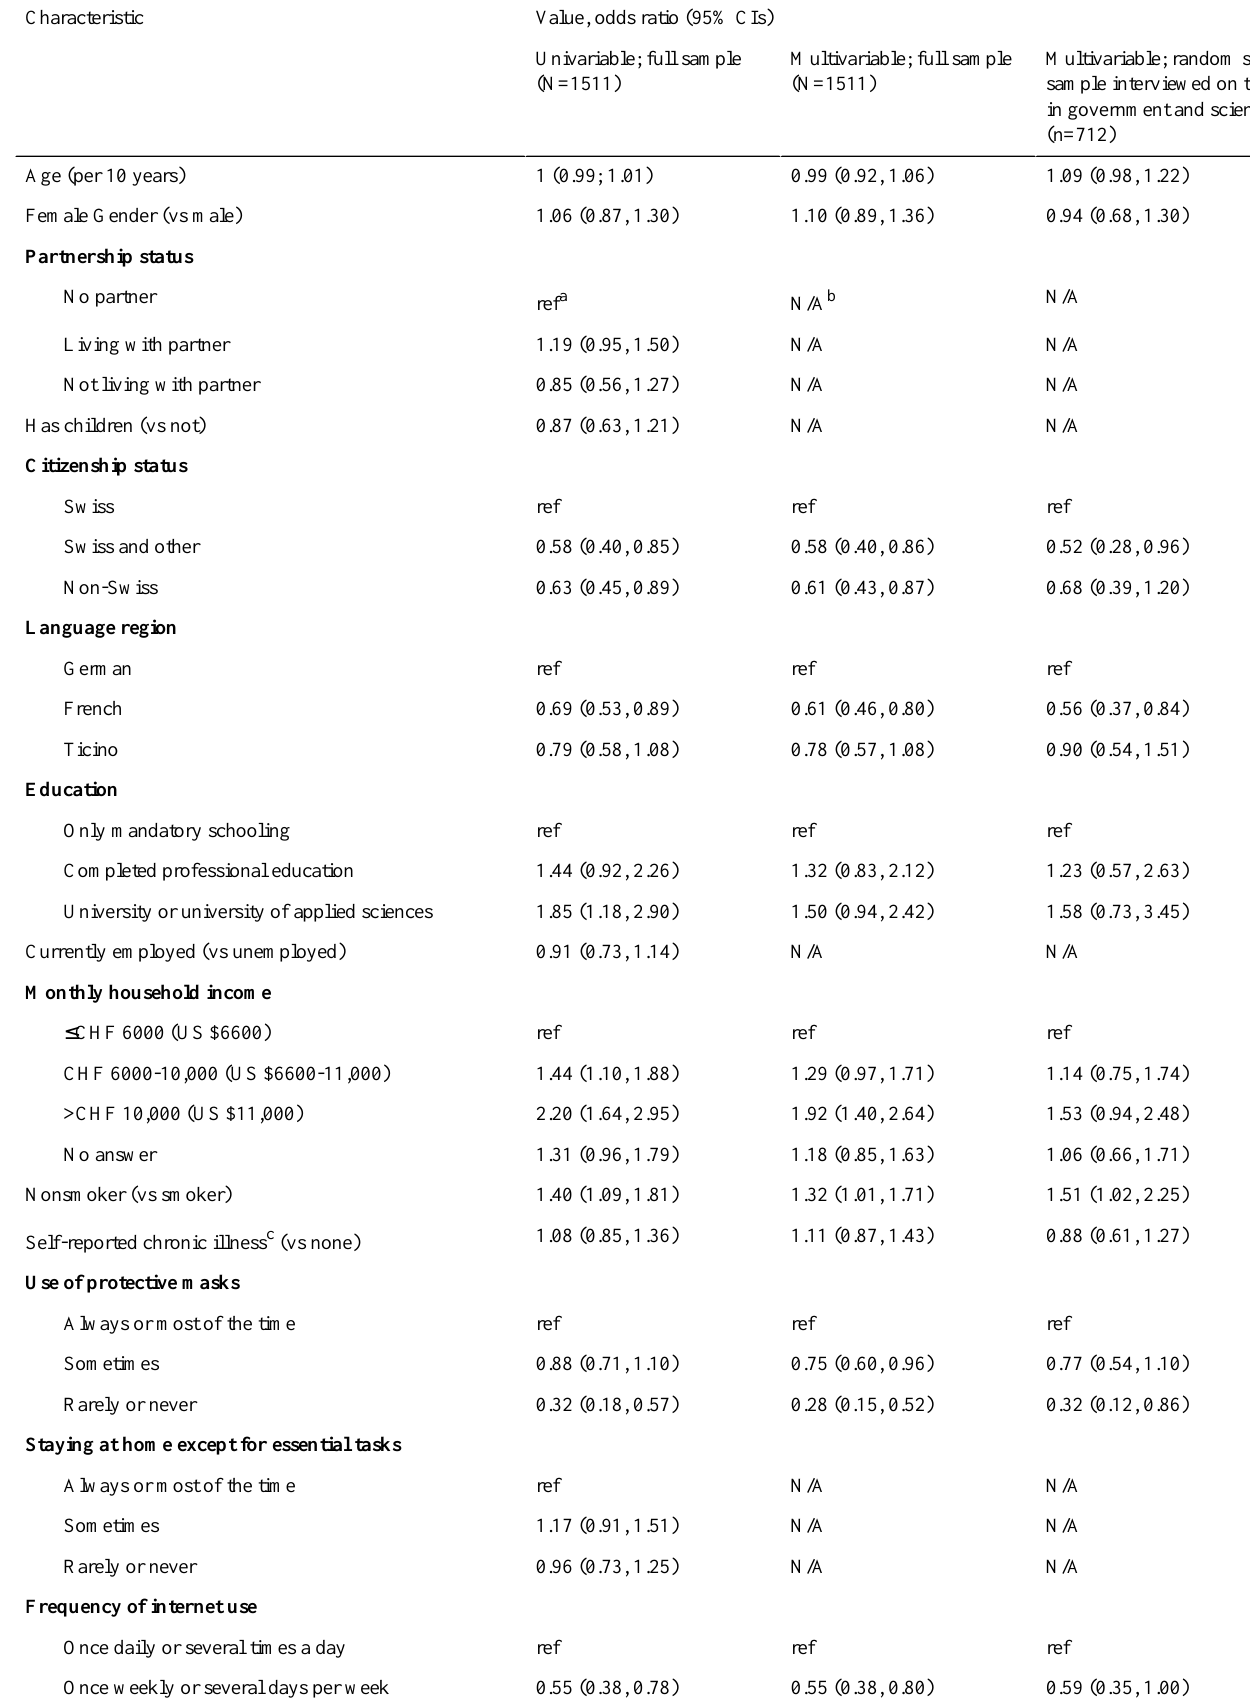
Table 2. Results of a multivariable logistic regression analysis investigating factors associated with the use of the SwissCovid app Value, odds ratio (95%